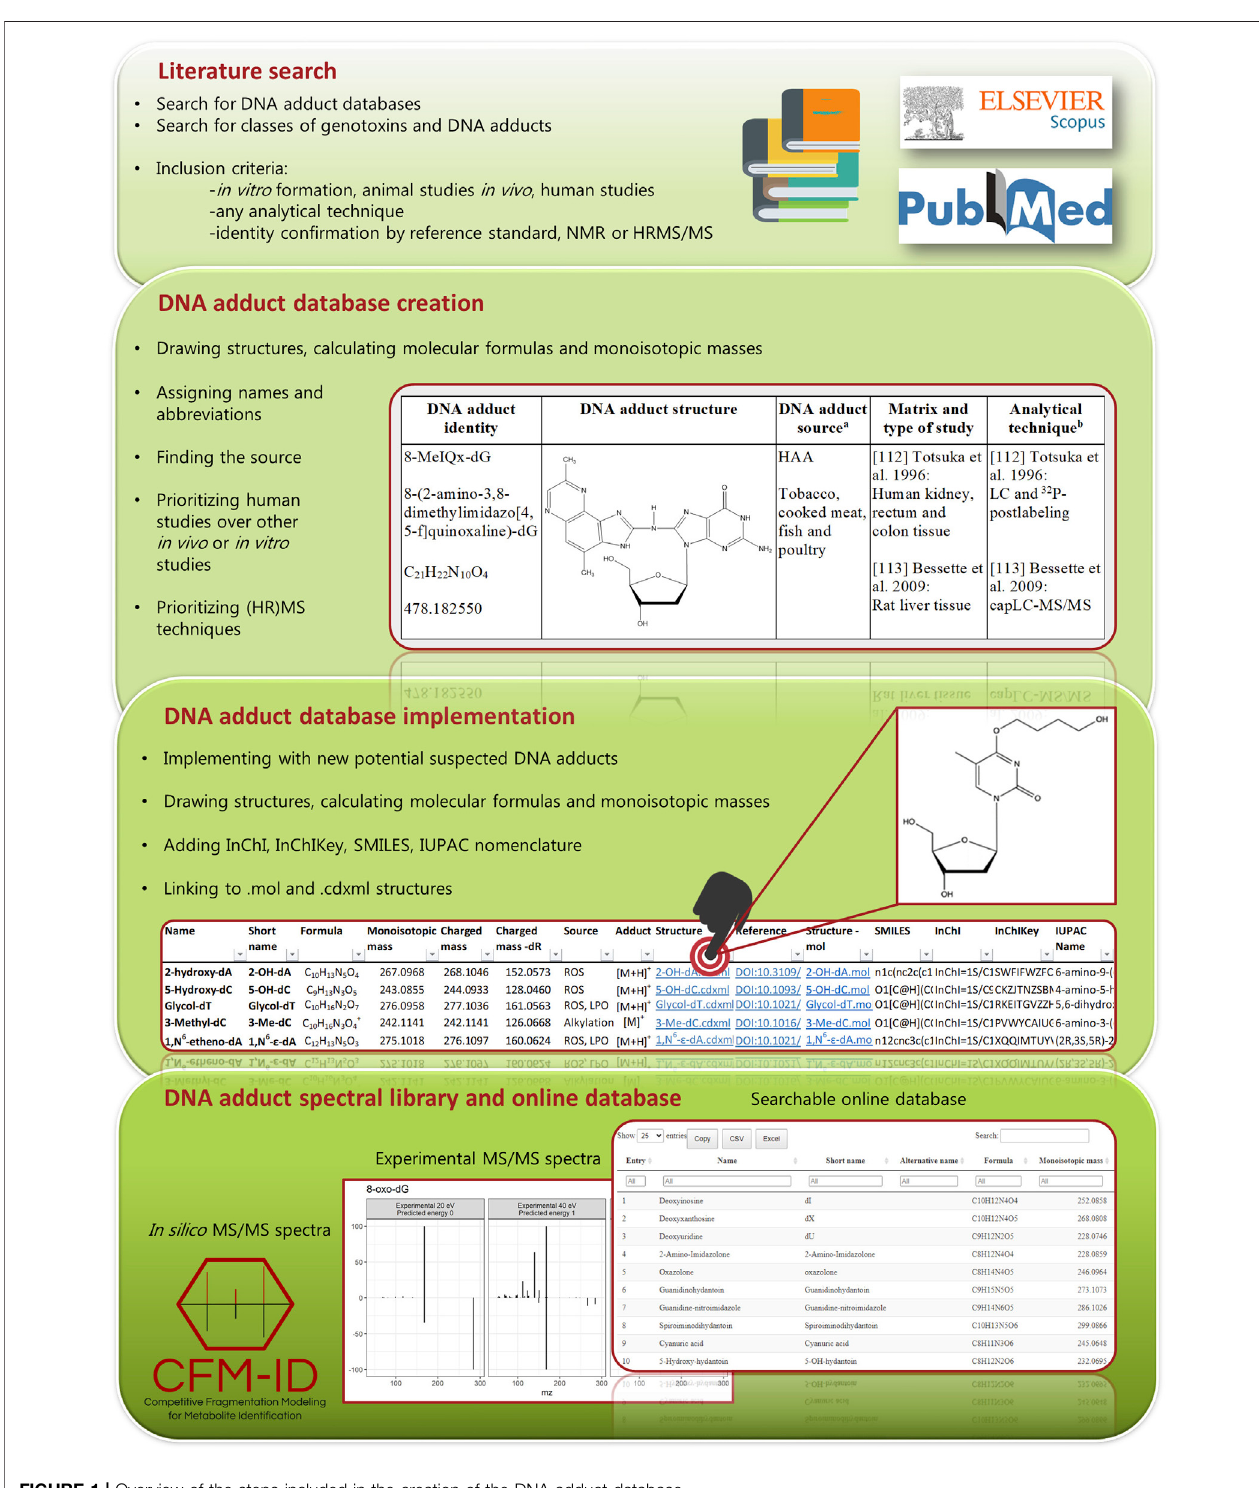
FIGURE 1 | Overview of the steps included in the creation of the DNA adduct database.